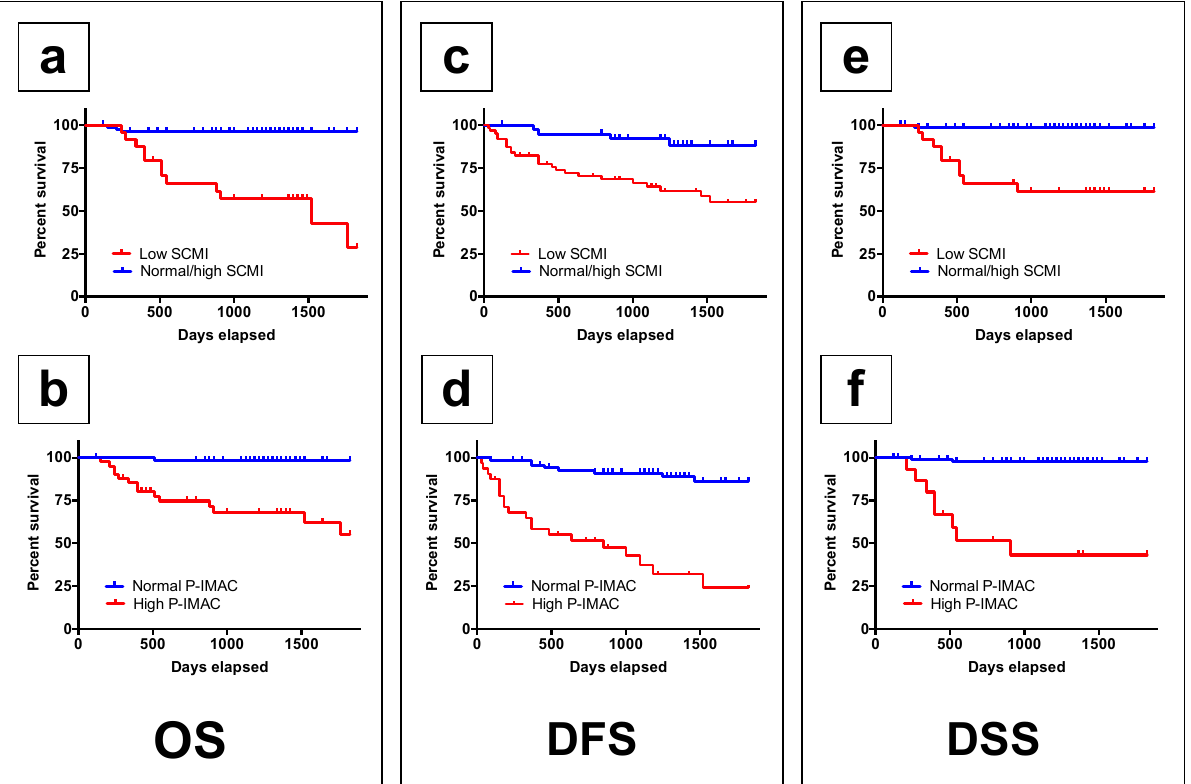
Figure 3. The low preoperative SCMI group and the high P-IMAC group had lower survival rates, respectively. ( a , b ) The overall survival rate in patients with a low SCMI and high P-IMAC was significantly lower than that in patients with a normal SCMI and normal P-IMAC, respectively ( p < 0.0001 and p < 0.0001); ( c , d ) the disease-free survival rates in patients with a low SCMI and high P-IMAC were significantly lower than those in patients with a normal SCMI and normal P-IMAC, respectively ( p = 0.0013 and p < 0.0001); ( e , f ) the disease-specific survival rates in patients with a low SCMI and high P-IMAC were lower than those in patients with a normal SCMI and normal P-IMAC, respectively ( p < 0.0001 and p < 0.0001). SCMI, sternocleidomastoid muscle mass index; P-IMAC, processus spinosus muscle—intramuscular adipose tissue content.